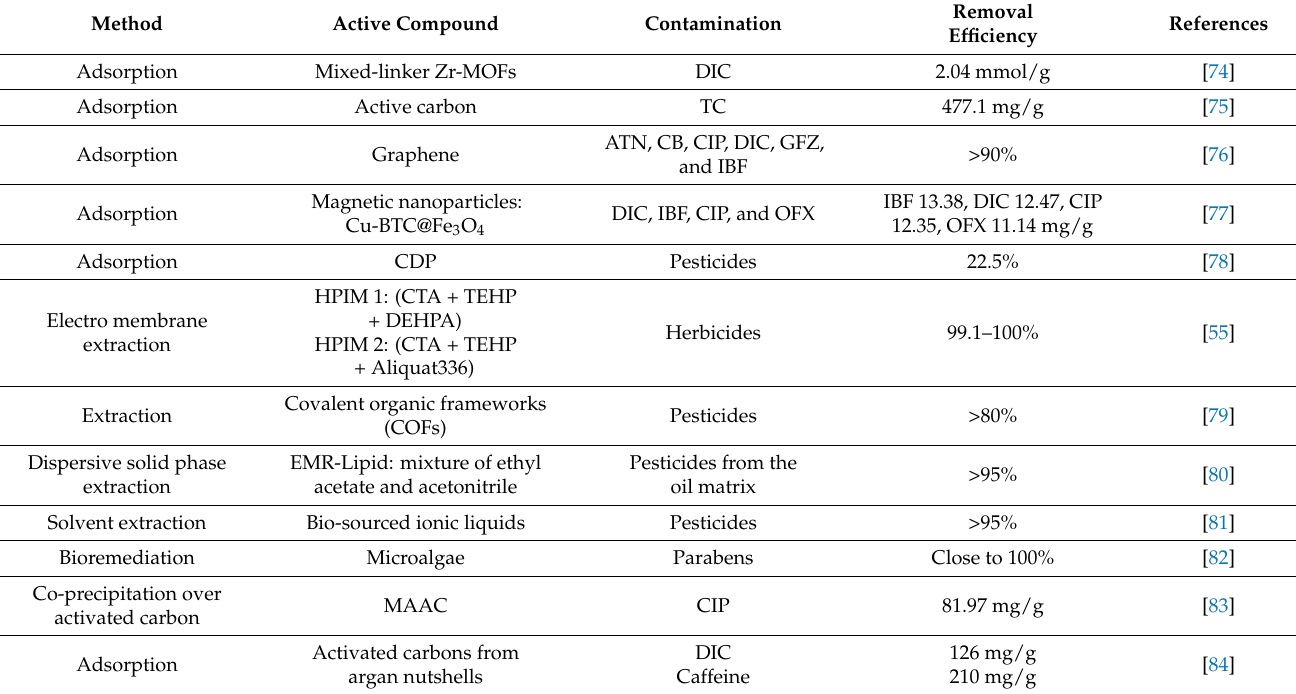
Table 4. Examples of using different methods to remove selected emerging contaminants from aqueous